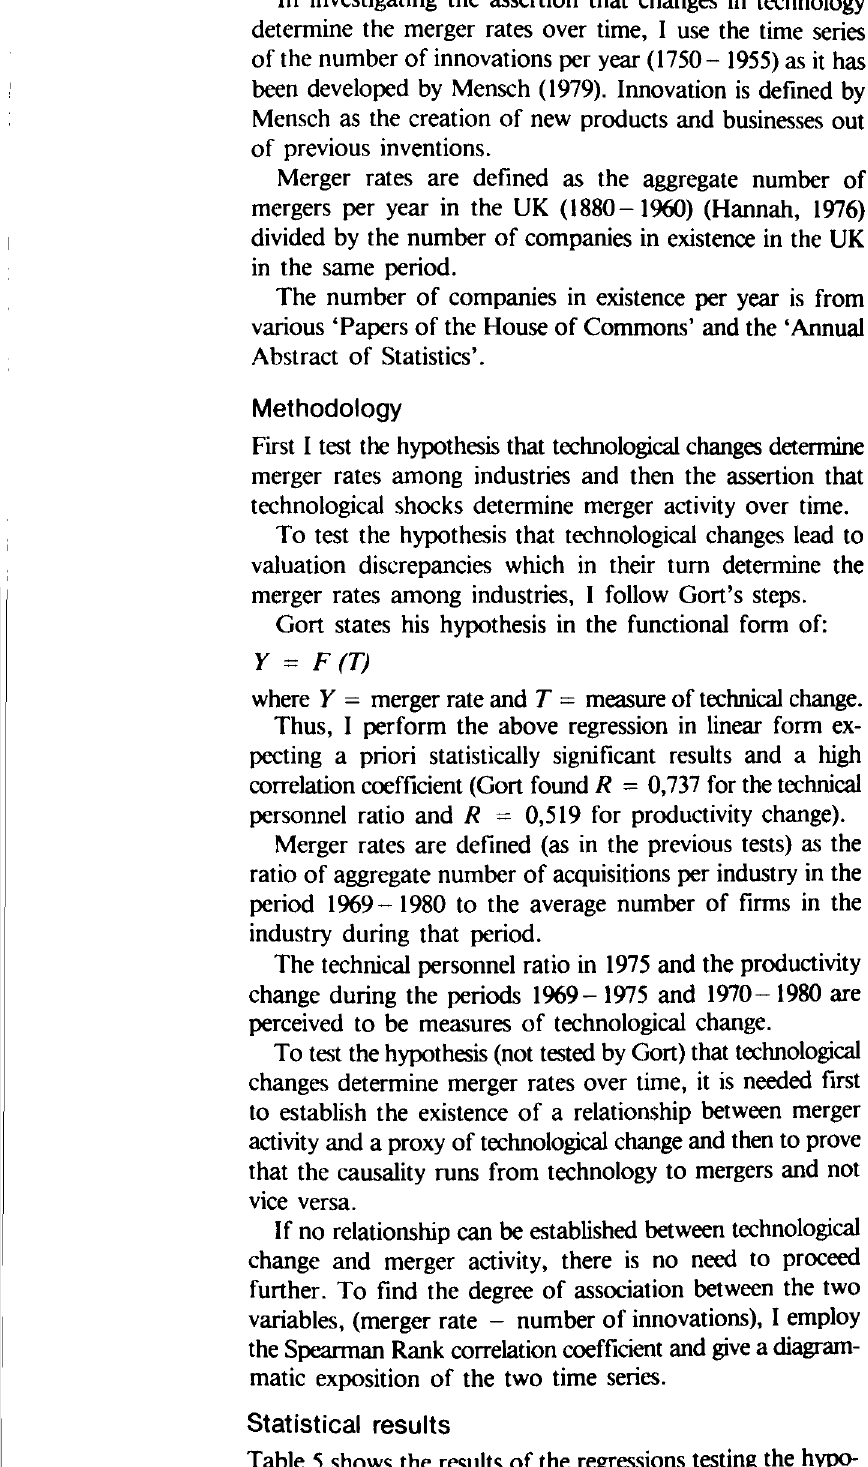
Figure 1 Merger activity and frequency of innovations